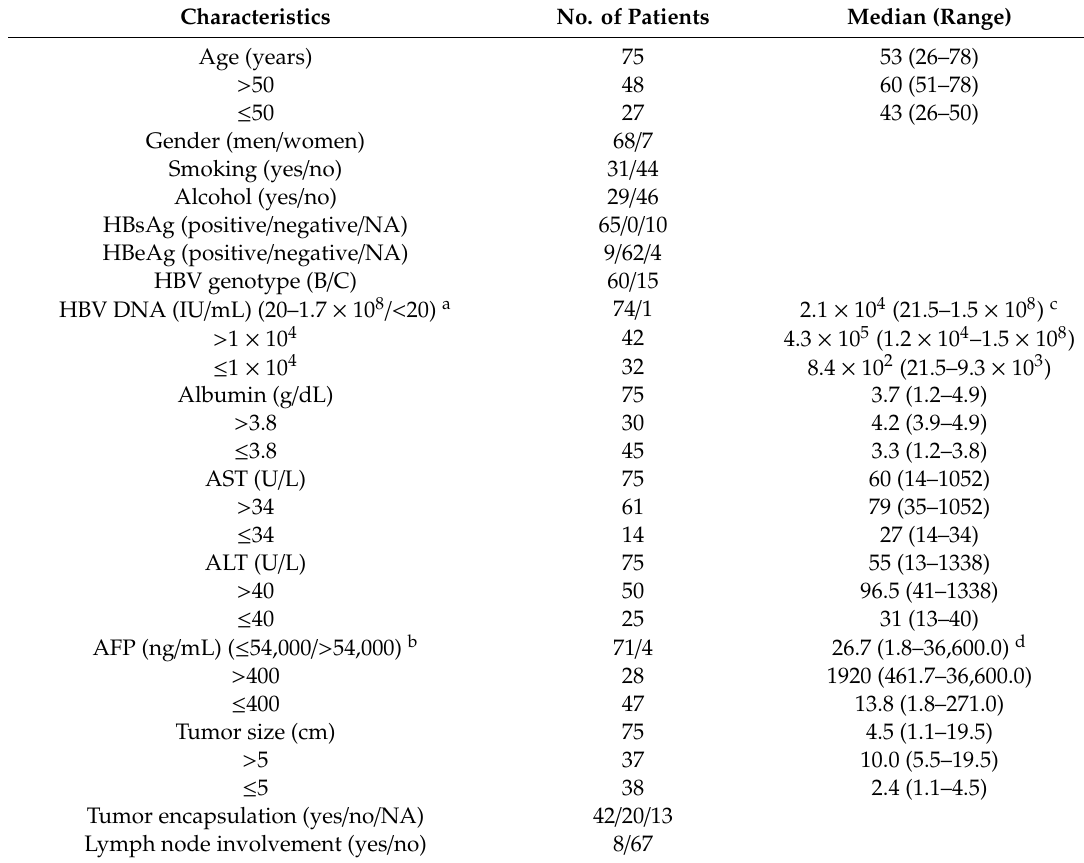
Table 1. Clinicopathological characteristics of 75 HBV-related HCC patients enrolled in this study.